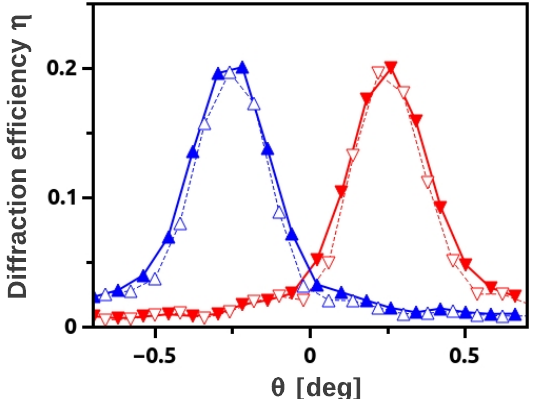
Figure 8. Background-corrected wavelength spectra of the intensity diffracted by a SiO NP-polymer composite grating at tilt angle ζ ≈ 70 ◦ for (a) θ far from θ ( N · · · − 1 st order, l . . . 0 th order, H · · · + 1 st order). The measurement time at each θ